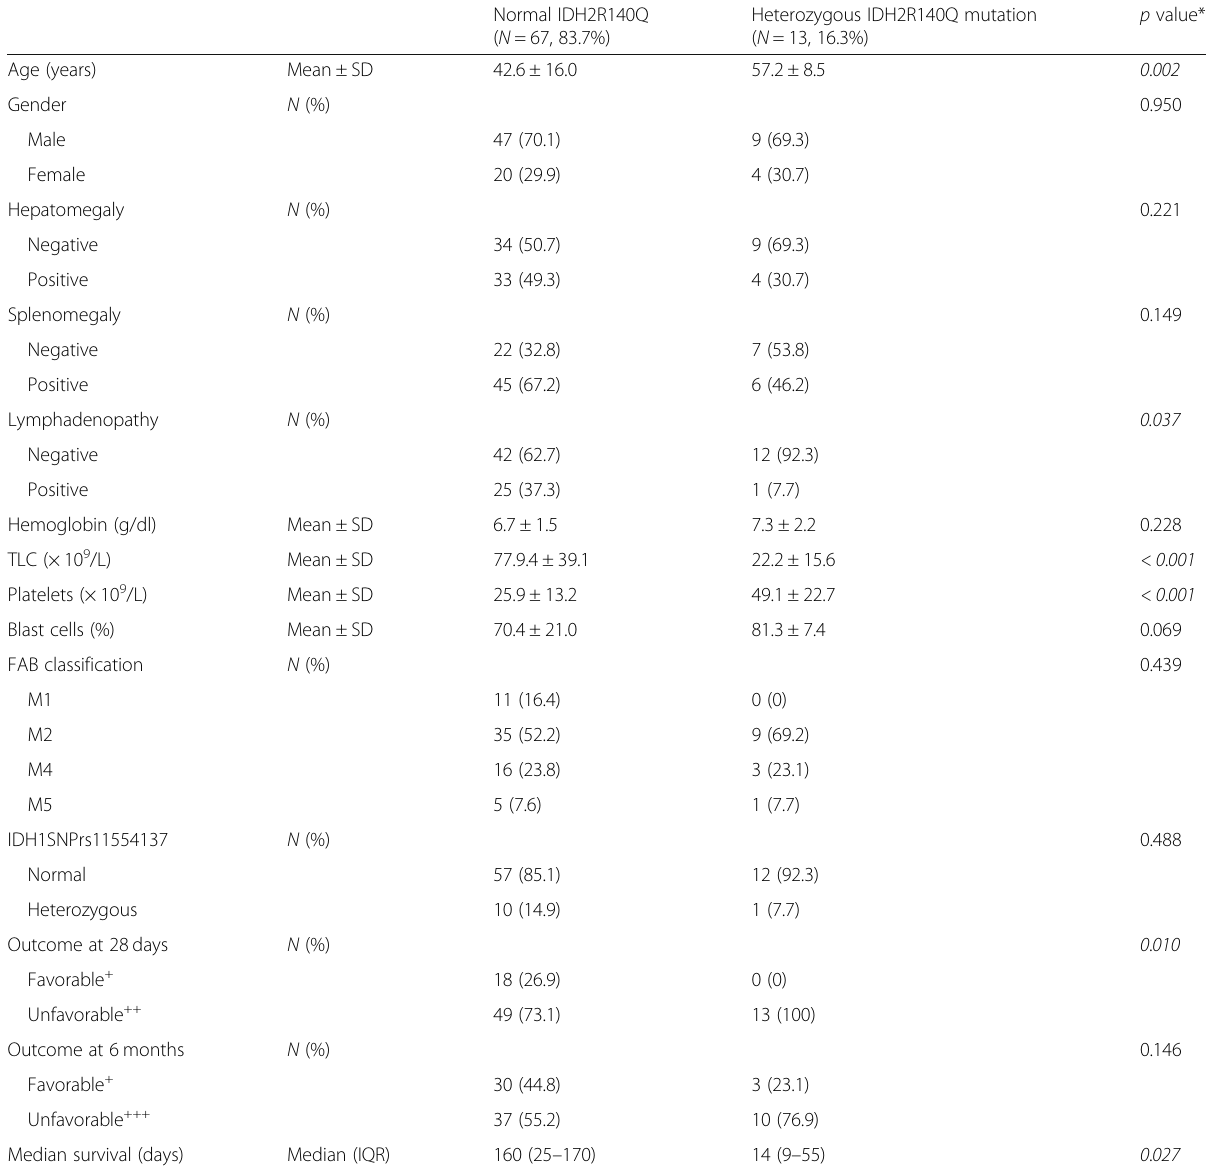
Table 4 Comparison between normal and mutant IDH2R140Q patients